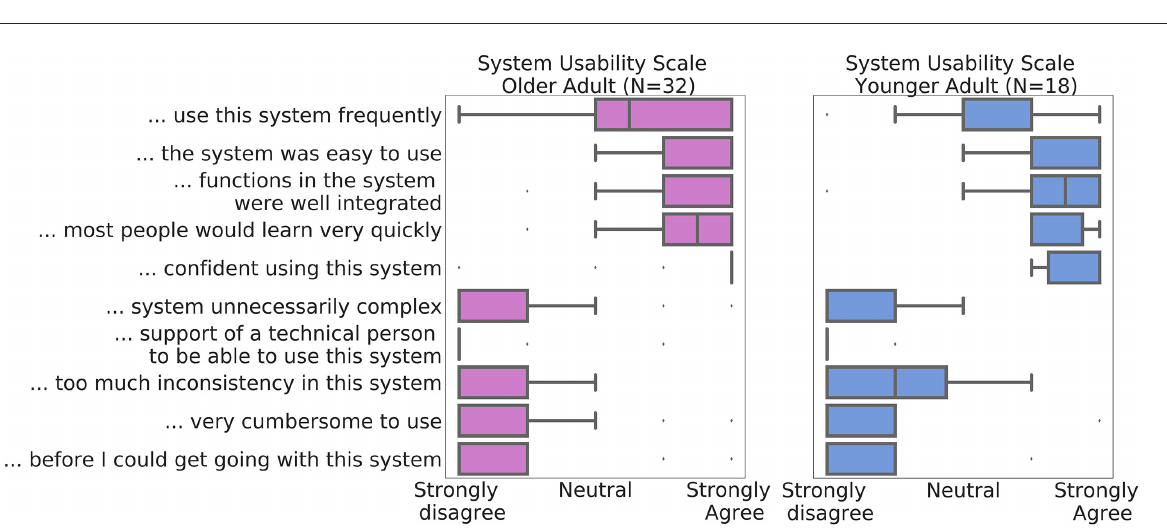
FIGURE5 Median System Usability Scale component scores across all participants in the Data of Older Adult study are depicted in purple ( N the Younger Adult Study in blue ( N